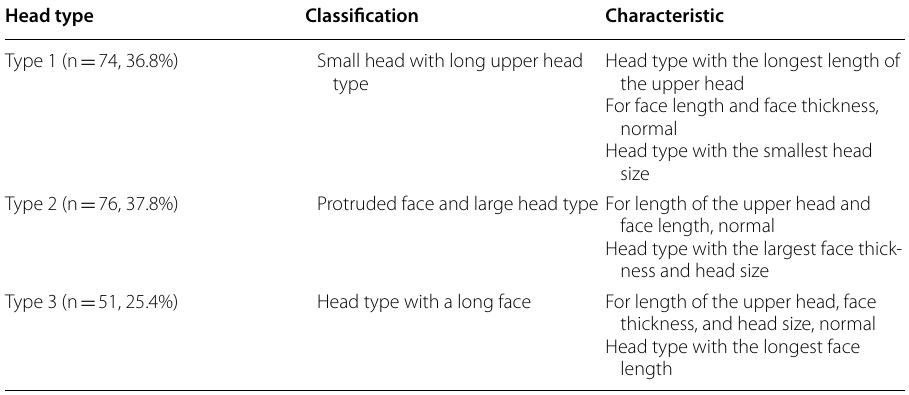
Table 4 Characteristics by head type by cluster classification of absolute values Head